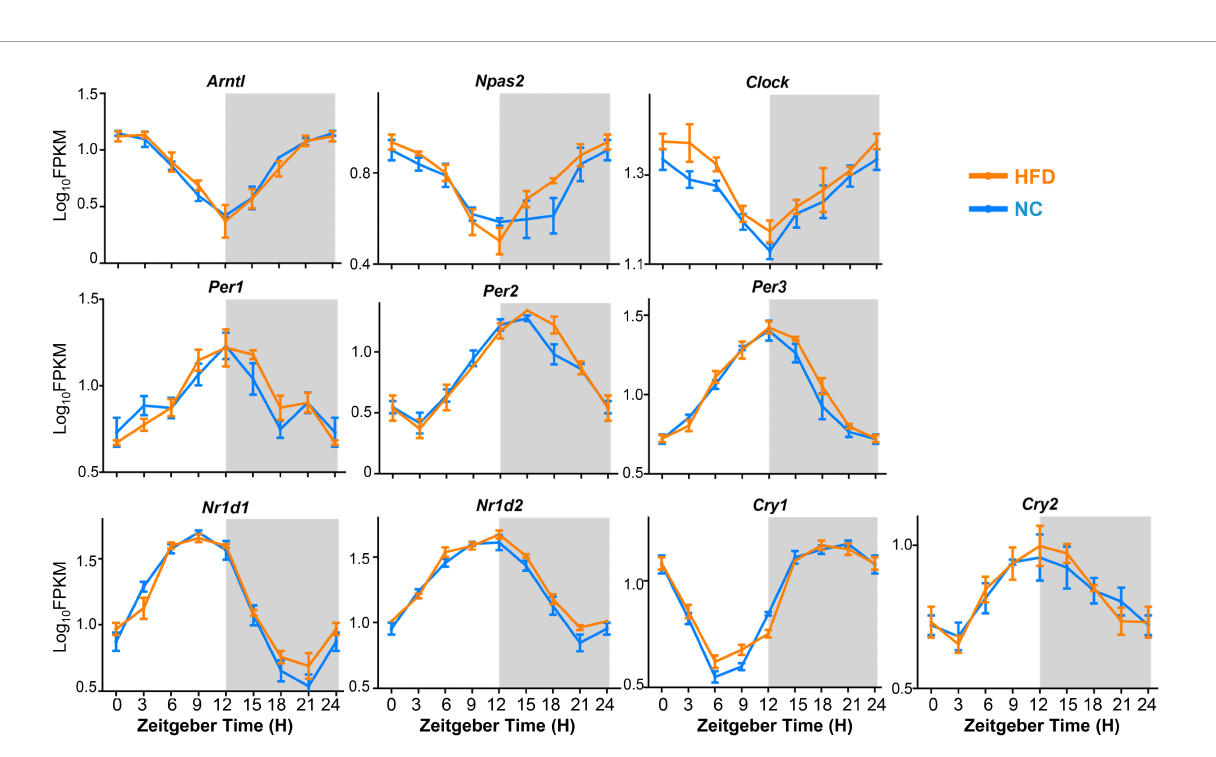
FIGURE5 Expression and oscillation patterns of core clock machinery genes in the MGs of NC- and HFD-fed mice. n = 3 mice per group for each sampling time point. Student’s t -test was performed for each ZT time point for the NC- and HFD-fed mice. Gray shading: dark phase.